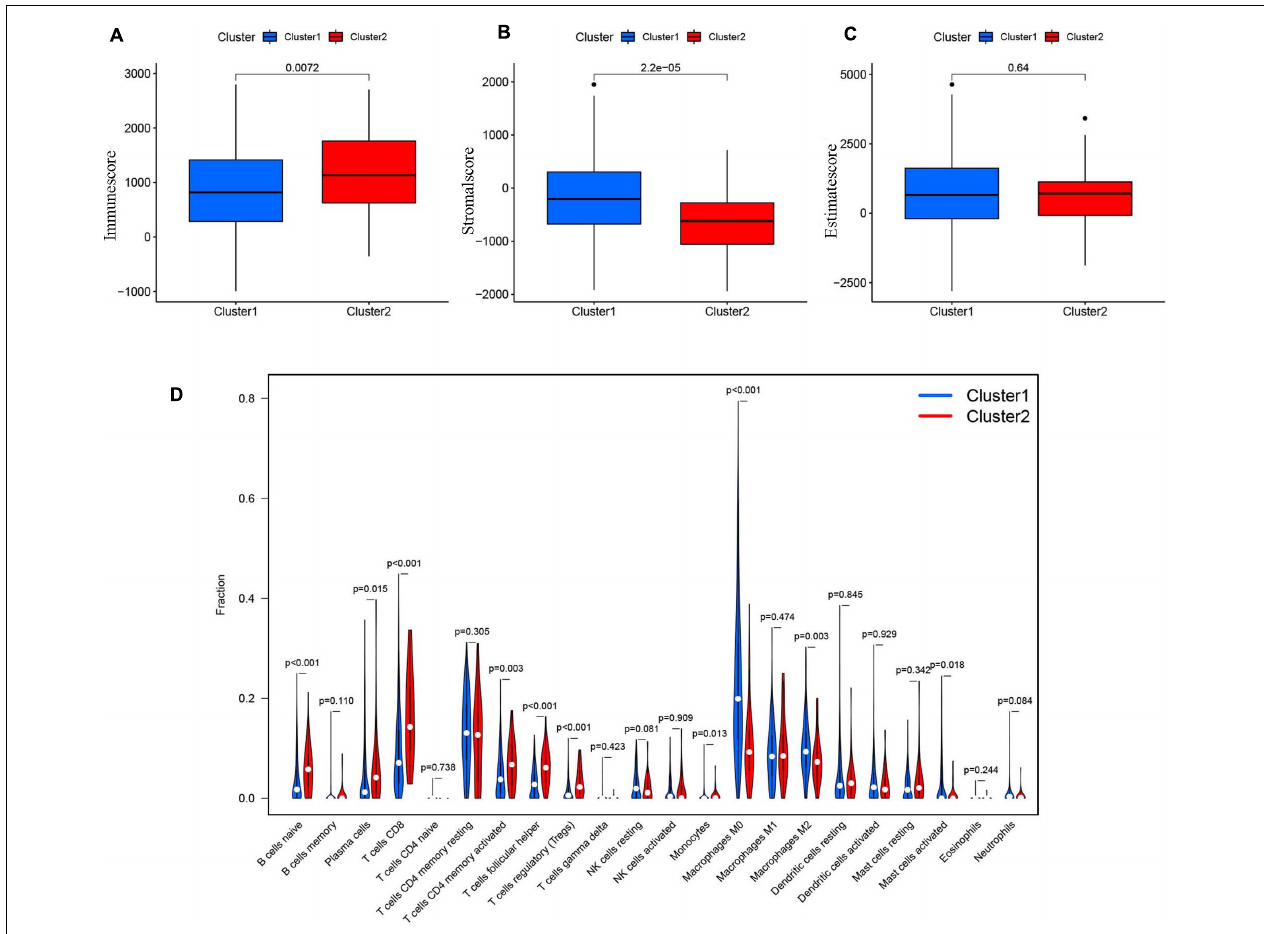
FIGURE 7 | (A) The Immunescore in cluster 1/2 subtypes in TCGA cohort. (B) The Stromal-score in cluster 1/2 subtypes in TCGA cohort. (C) The Estimatescore in cluster 1/2 subtypes in TCGA cohort. (D) The infiltrating levels of 22 immune cell types in clusterl/2 subtypes in the TCGA cohort.